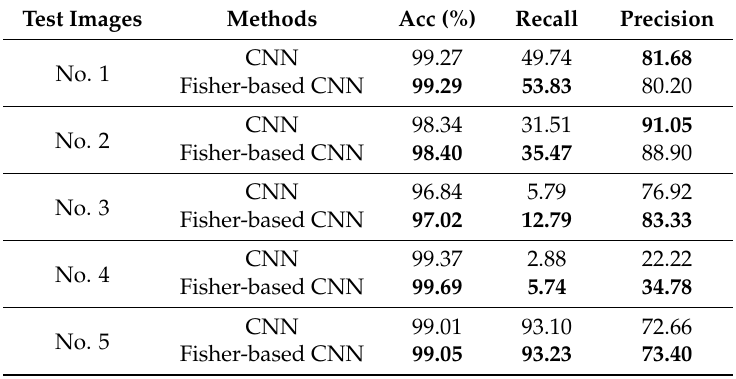
Table 3. Accuracy improved by Fisher criterion (the best results are marked in